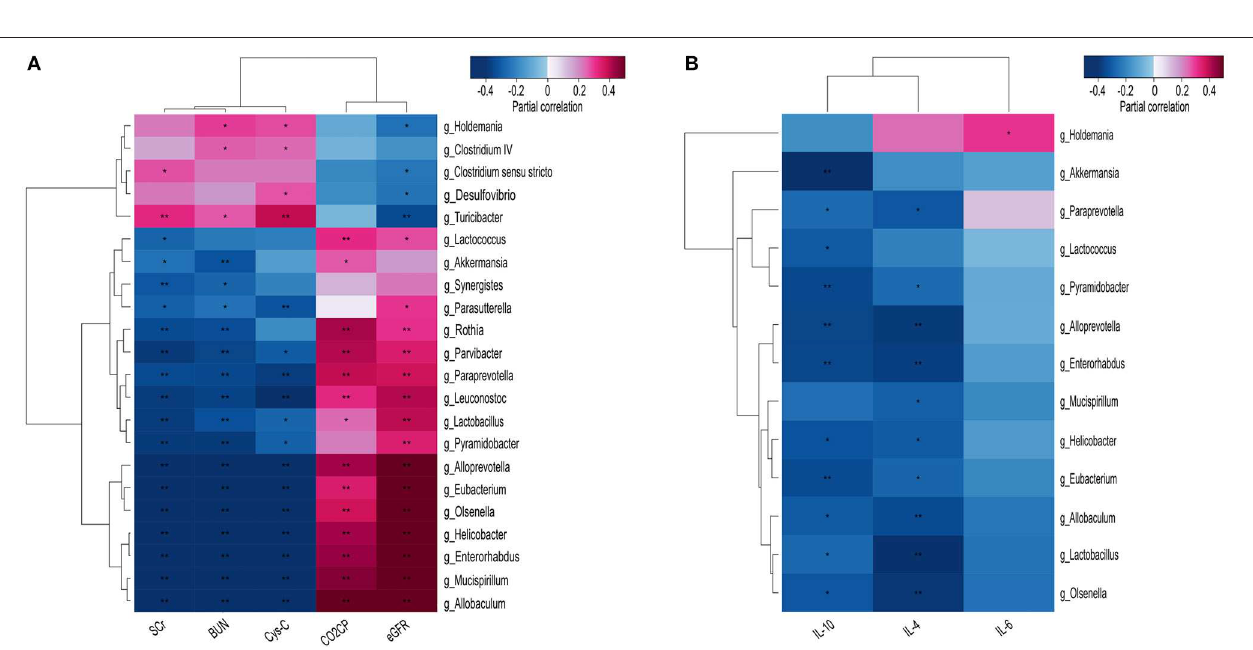
FIGURE 3 | Receiver operating characteristic curve (ROC) analysis of the sensitivity and specificity of the differentially abundant genera as diagnostic factors for chronic kidney disease (CKD). The conducted analysis suggests that the relative abundances of (A) Akkermansia , (B) Lactobacillus , and most particularly, (C) of both Akkermansia and Lactobacillus , are likely promising diagnostic factors to distinguish between patients with CKD and healthy control (HC) subjects.